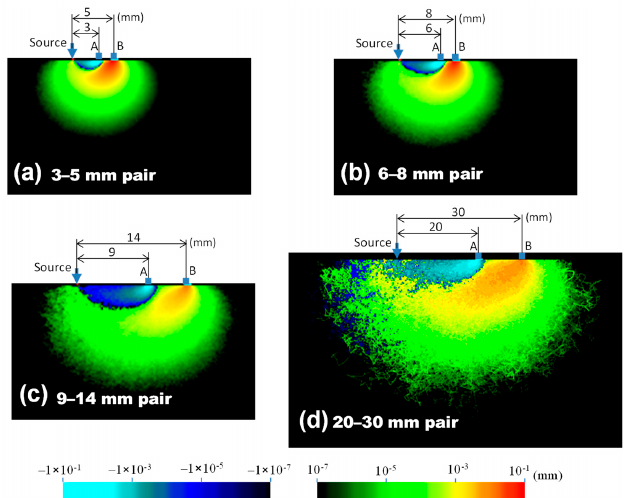
Figure 2. Simulation results for the measurement sensitivity distribution in a homogeneous medium with four SRS probes. The combination pairs for the two detectors of the probe were a ( a ) 3–5 mm pair, ( b ) 6–8 mm pair, ( c ) 9–14 mm pair, and ( d ) 20–30 mm pair.